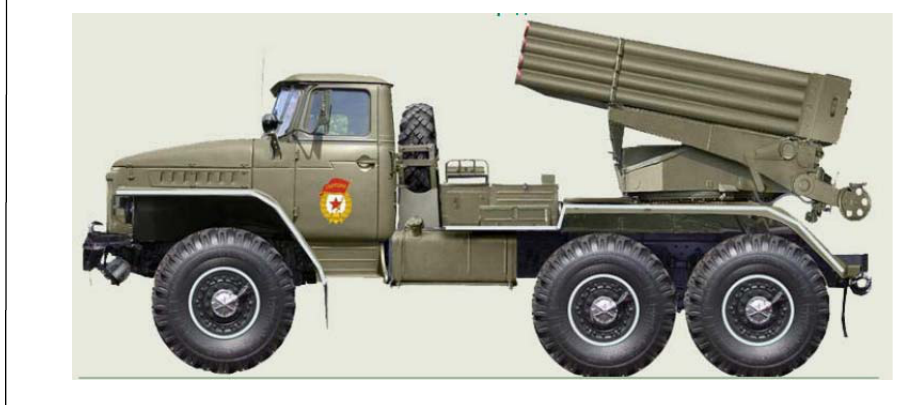
Figure 1 – Mobile launcher RSZO BM-21 Рис . 1 – Мобильная пусковая установка РСЗО БМ -21 Слика 1 – Самоходни вишецевни бацач ракета РСЗО БМ